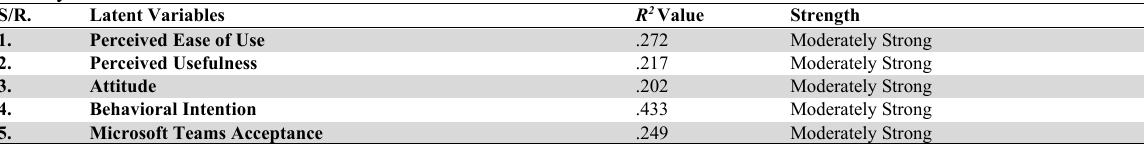
R 2 Analysis of Latent